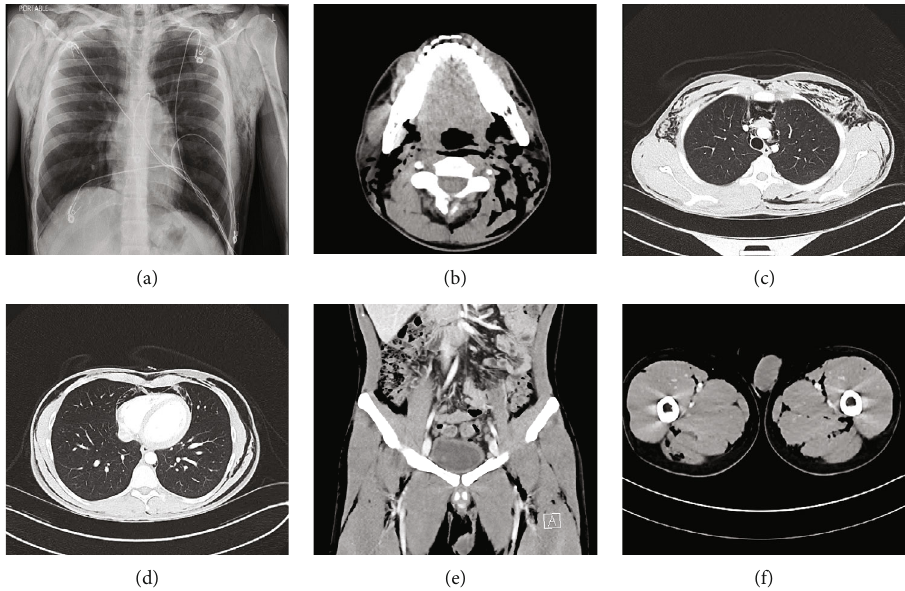
Figure 1: (a) Chest x-ray with pneumomediastinum with subcutaneous air in the chest wall and neck. (b) CT head with subcutaneous emphysema. (c, d) CT Chest with pneumomediastinum and extensive subcutaneous and soft tissue emphysema throughout the chest and back without signs of a pneumothorax. (e, f): CT Abdomen with pneumoperitoneum and extensive soft tissue emphysema dissecting into the pelvis and bilateral lower extremities beyond the inguinal